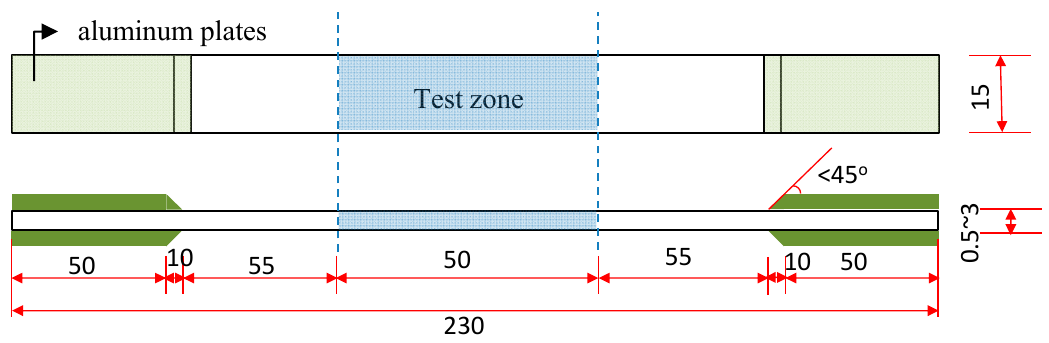
Figure 3. Details of FRP sheet specimens (in mm).